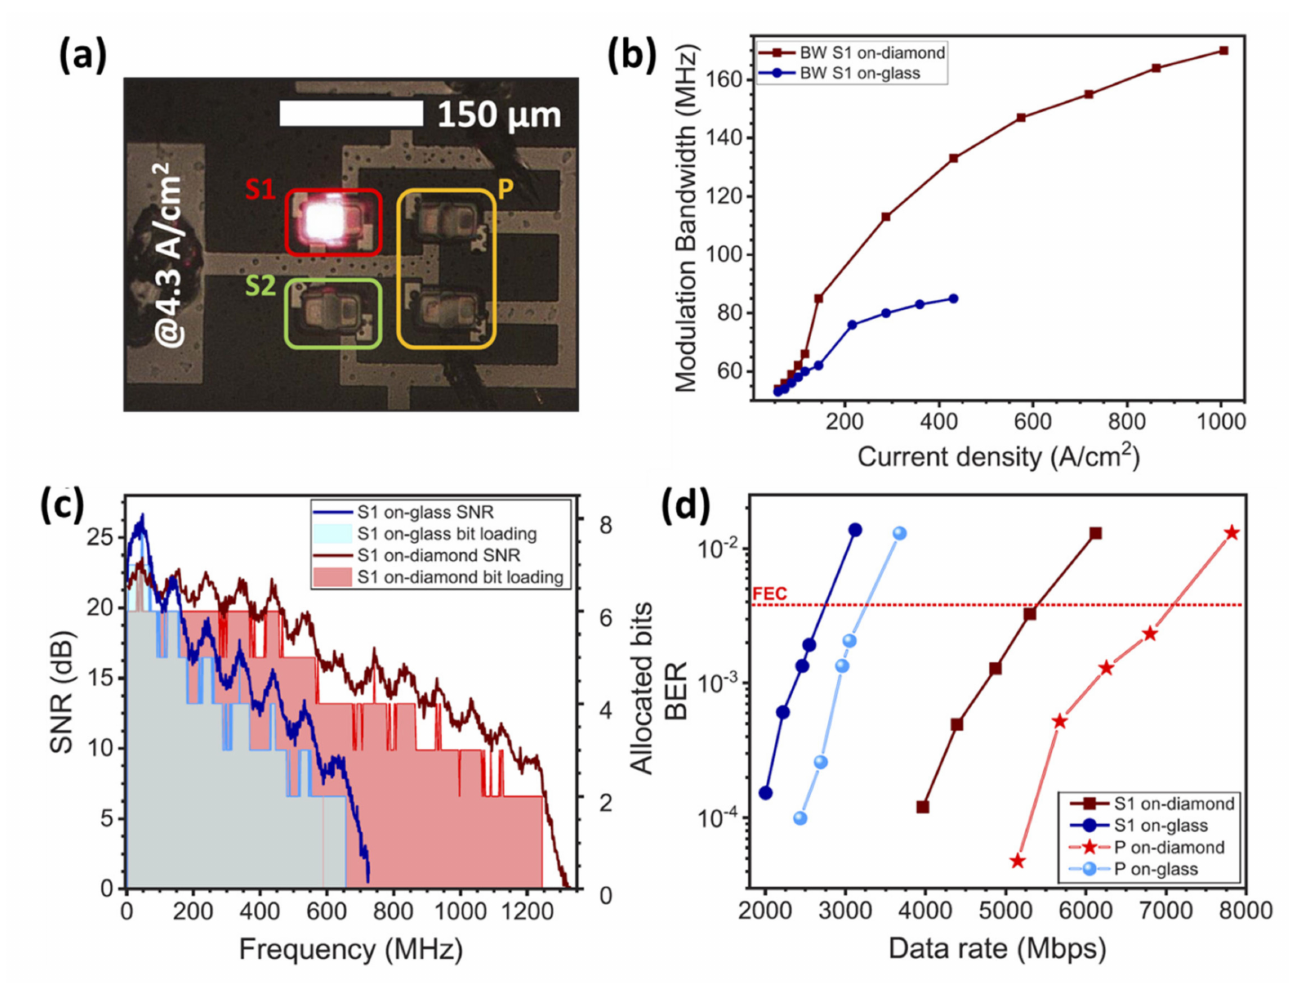
Figure 10. ( a ) Single micro-LED (S1) and in-parallel micro-LED array (P) on glass driven at 4.3 A/cm 2 . ( b ) Modulation bandwidth vs. current density for the single micro-LED on both substrates. ( c ) SNR and number of allocated bits vs. frequency for single micro-LEDs on both substrates. ( d ) BER vs. data rate for single and in-parallel micro-LEDs on both substrates. Ref. [65] Figures reproduced with permission from Optica Publishing